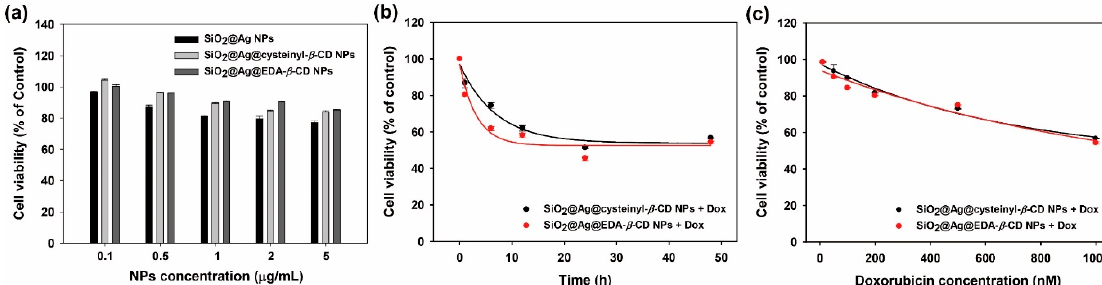
Figure 6. Assessment of cytotoxicity in cancer cells treated with Ag-embedded SiO 2 nanocarriers. ( a ) MCF-7 cancer cells were treated with each type of NP at increasing concentrations (0.1–5 µ g/mL) for 48 h. The cell viability was measured using the WST-1 assay. ( b ) Cell viability after treatment with cysteinyl- β -CD and EDA- β -CD loaded with 1 µ M DOX with increasing incubation time (1, 6, 12, 24 and 48 h). The cytotoxicity rate was obtained by fitting with an exponential equation (lines). ( c ) Cell viability after treatment with various concentrations of DOX-loaded cysteinyl- β -CD and EDA- β -CD NPs for 48 h. The decrease in cell viability with increasing DOX was fit to the hyperbolic equation